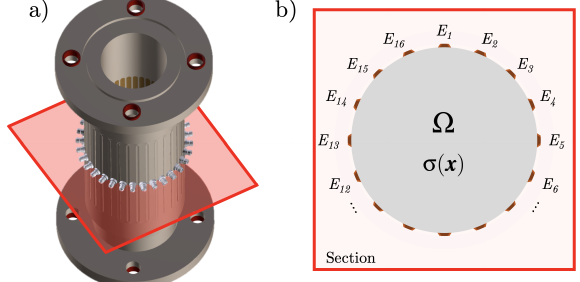
Figure 1. ( a ) Scheme of the EIT sensor prototype of height 336 mm, external diameter 120 mm, and inner diameter 80 mm containing 32 electrodes of length 150 mm and width 6 mm. In the current experiment, one over two, 16 electrodes are connected to coaxial cables with the SubMiniature Version A (SMA) connectors, also shown in the figure. ( b ) Representation of the 16 electrodes in the cross-section of the EIT